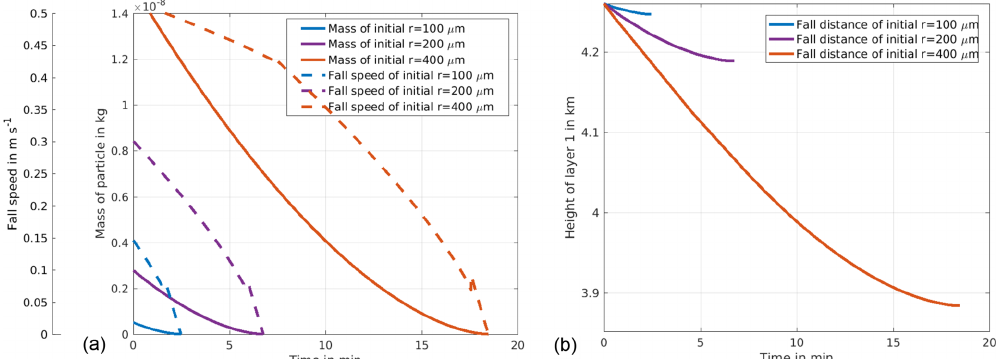
Figure 4. Calculation of sublimation for layer 1 between 4.26 and 3.85km height on 3 November 2016. (a) Fall speed and change in mass of ice crystals with time. (b) Fall distance of ice crystals with time. The evaluated ice crystals are hexagonal plates with the initial sizes r = 100, 200 and